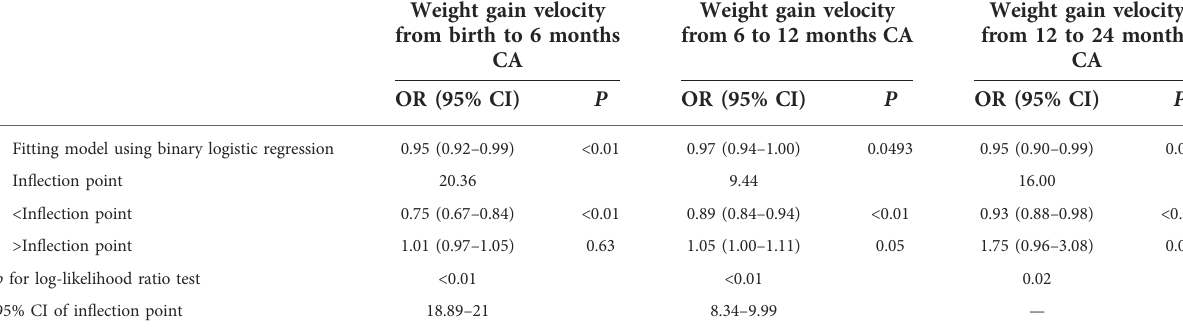
TABLE 3 Nonlinearity of weight gain velocity in different periods on neurodevelopmental